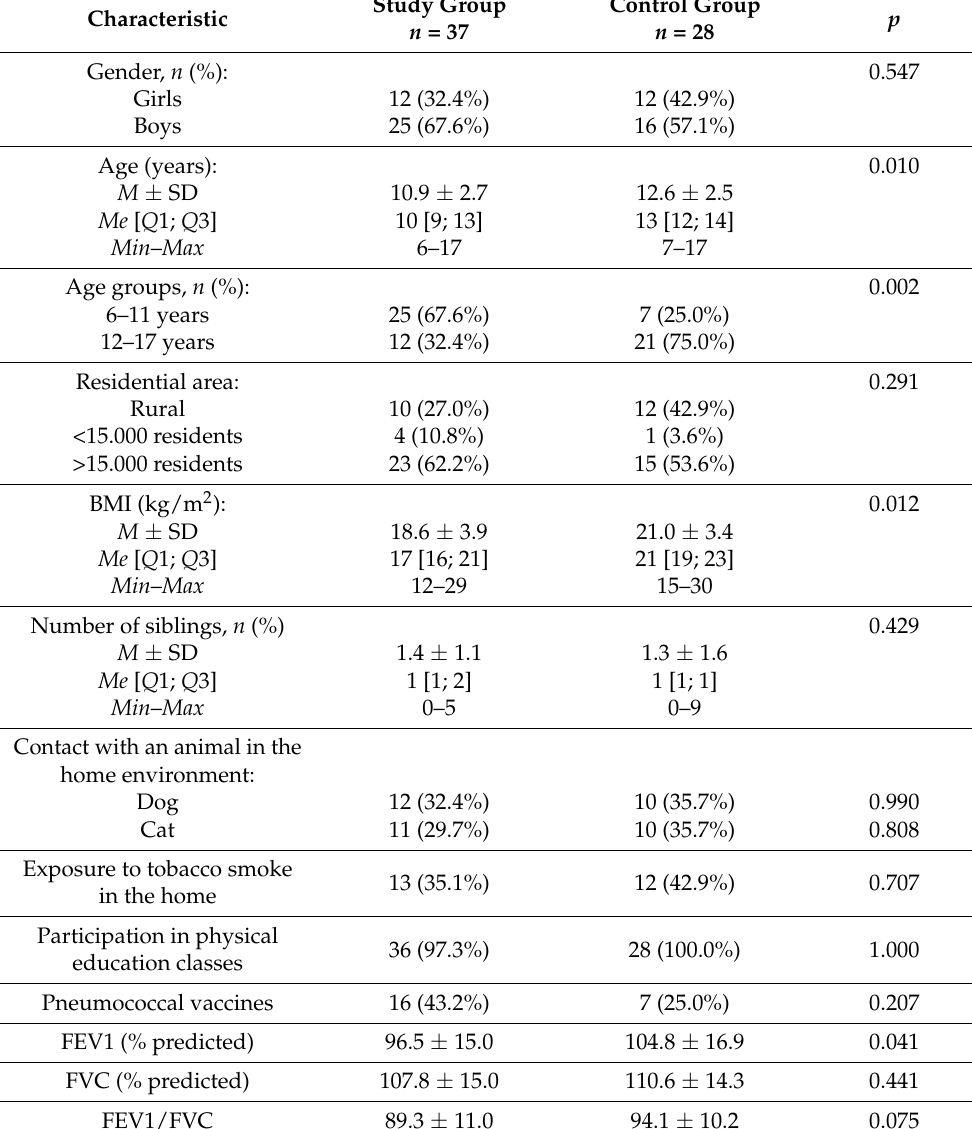
Table 1. Patients’